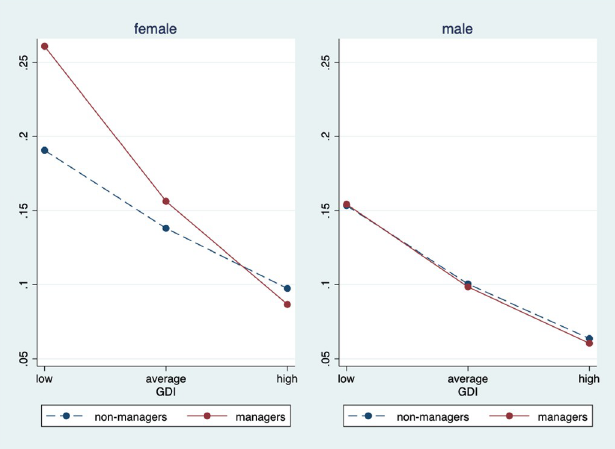
Fig 1. Predicted probability of restless sleep by gender development index score, (based on Model